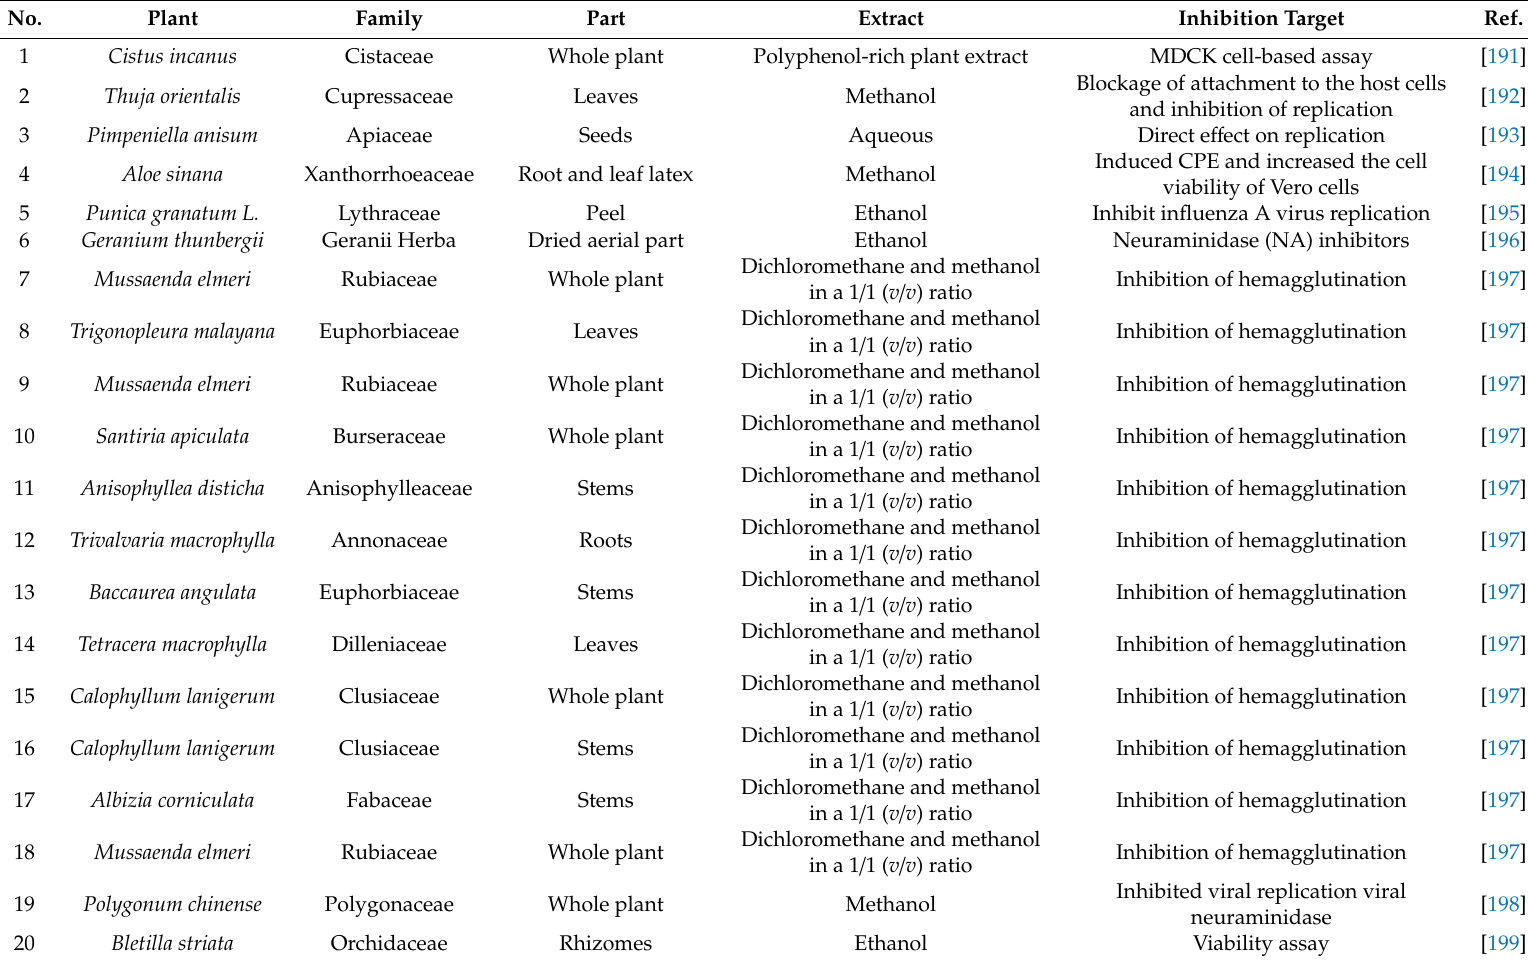
Table 5. Review of the plants that have shown anti-flu virus activities with their prospective family, part, type of extract, and inhibition target. No. Plant Family